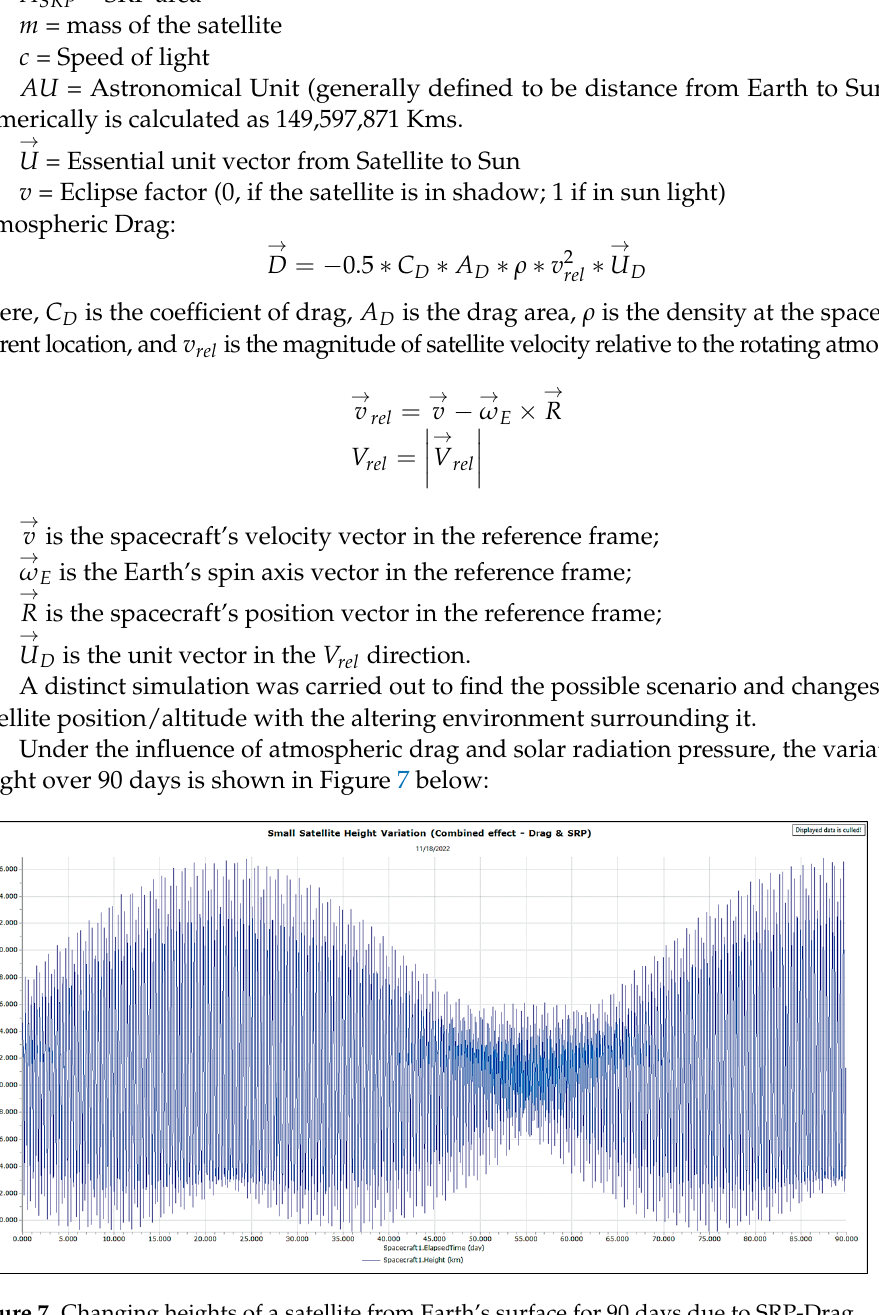
Figure 7. Changing heights of a satellite from Earth’s surface for 90 days due to SRP-Drag. Now, instead of height, apogee and perigee heights along with solar flux were calcu- lated to observe the environmental variations and subjected to propagation for 90 days as shown in Figure 8 and Figure 9.